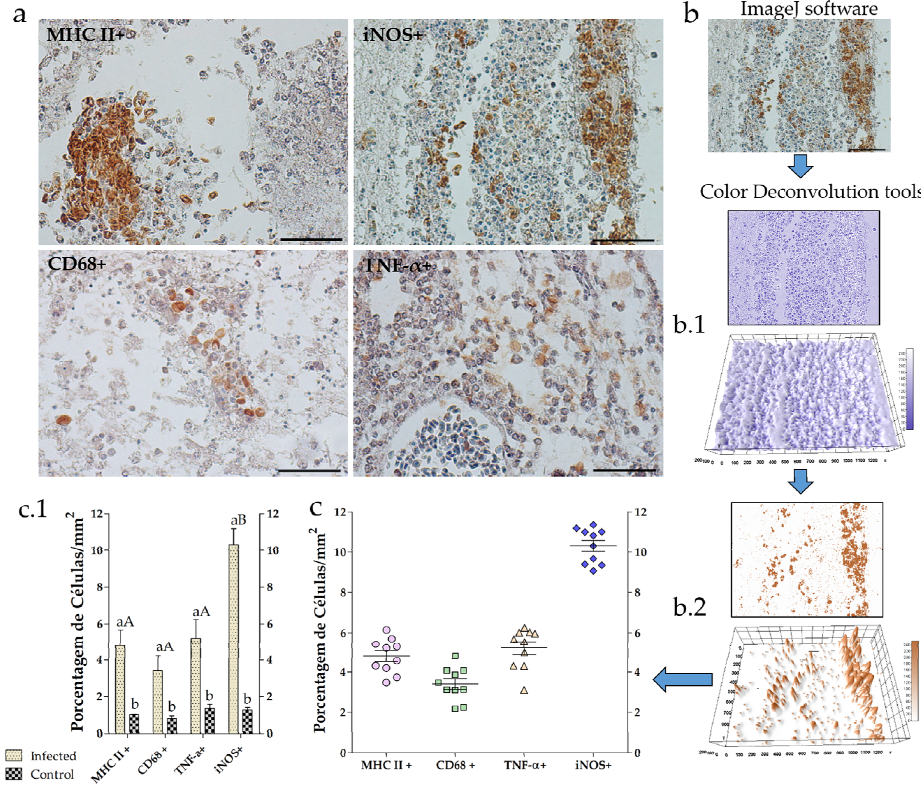
Figure 2. Neuroinflammatory process in the brain of Nile tilapia ( Oreochromis niloticus ) infected with S. agalactiae . ( a ) Representative images of the distribution of MHC class II+, CD68+, TNF- α and iNOS+ cells in meningeal. ( b ) Software ImageJ, using Deconvolution tools that separate the image in nuclear bodies (hematoxylin) ( b.1 ) and the immunostaining in DAB (brown) ( b.2 ) and ( c , c.1 ) the quantification analysis. Means and respective standard deviations ( n = 10) are shown; different letters indicate significant differences (Tukey’s test, p < 0.05) between the observed histologically stained regions; ns = not significant. Bar = 50 μ m, DAB = immunostaining (brown), counter stained with Harris hematoxylin.